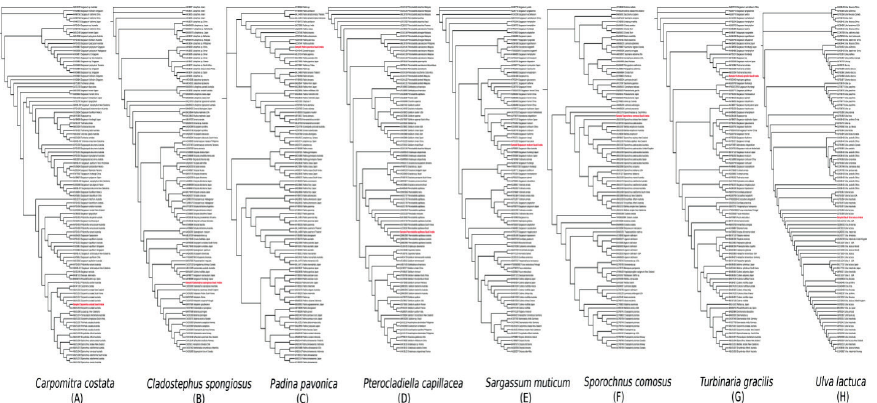
Fig. 4 . The phylogenetic trees depicting the relationship between different seaweeds specimens and GenBank